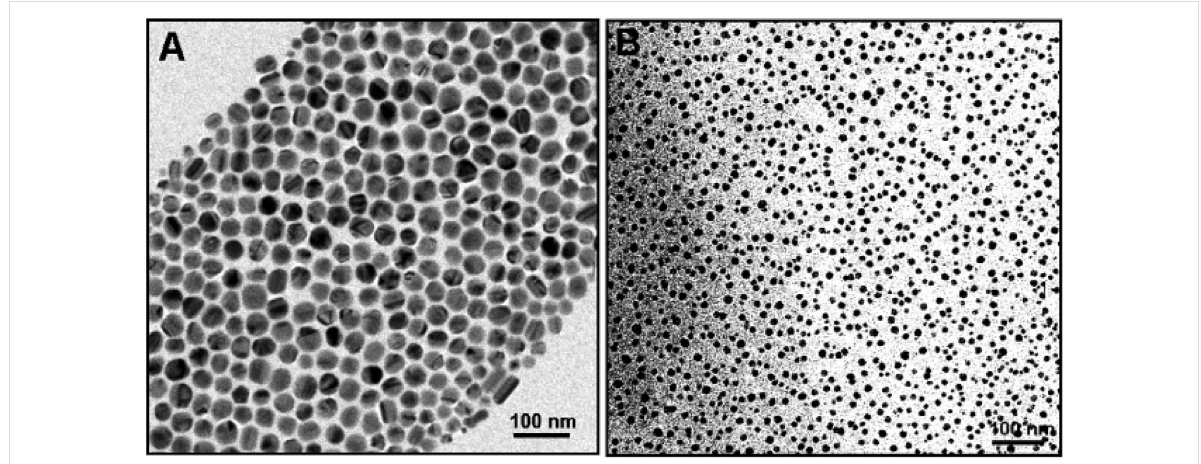
Figure 2: TEM images of Ag colloids synthesized at 120 °C for 8 h. Reproduced with permission from [145]; Copyright (2005) American Chemical Society.